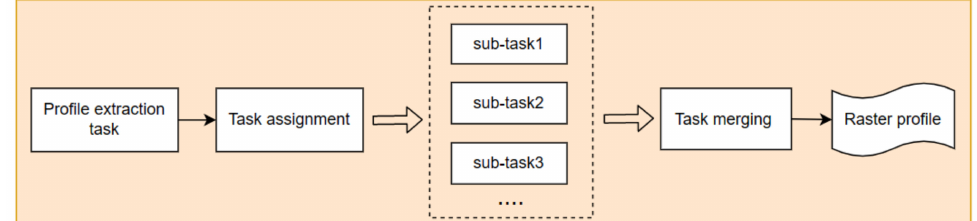
Figure 8. Parallel algorithm flow